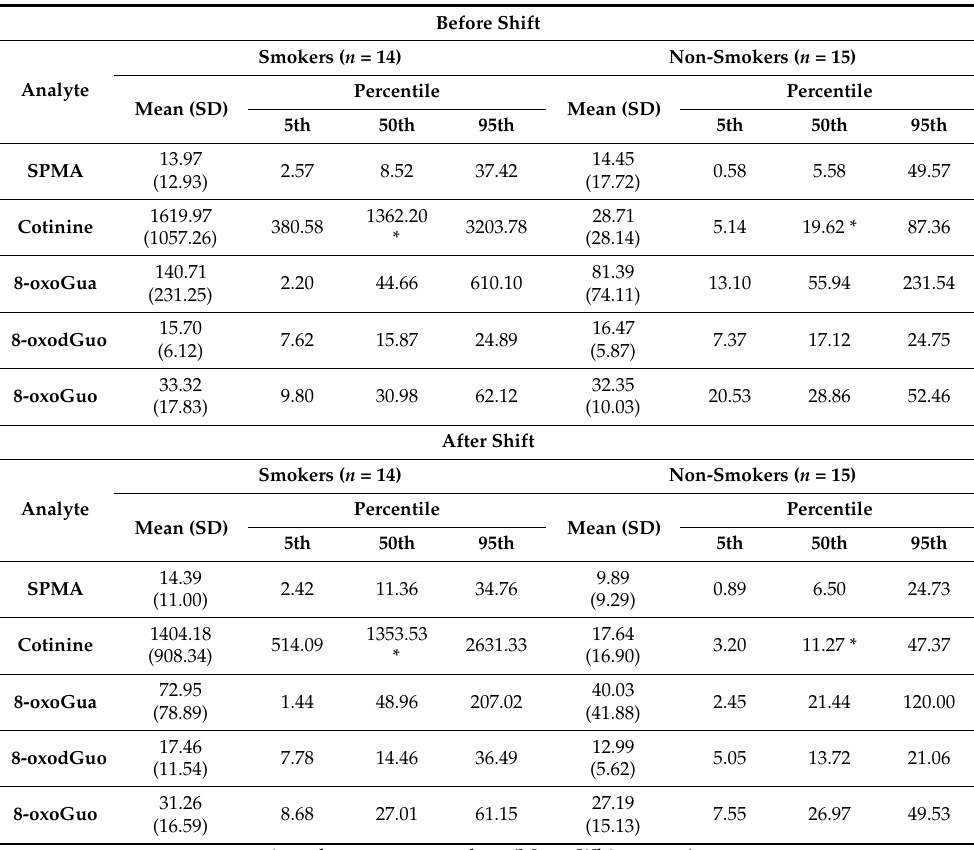
Table 3. Concentrations ( µ g/g creatinine) of metabolites for the chemical exposure (SPMA and cotinine) and the oxidation biomarkers (8-oxoGua, 8-oxodGuo and 8-oxoGuo) in Group 1, before and after shift, stratified by smoking habit.